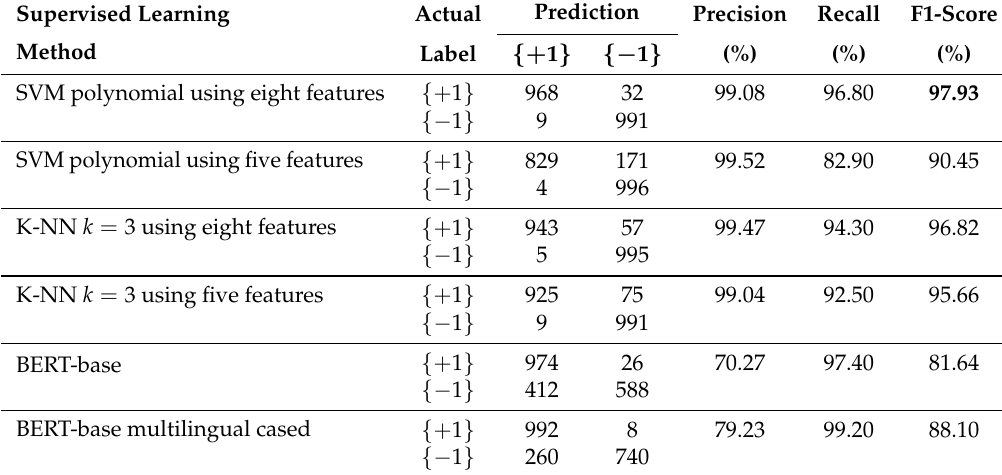
Table 3. Evaluation results of all the methods using test